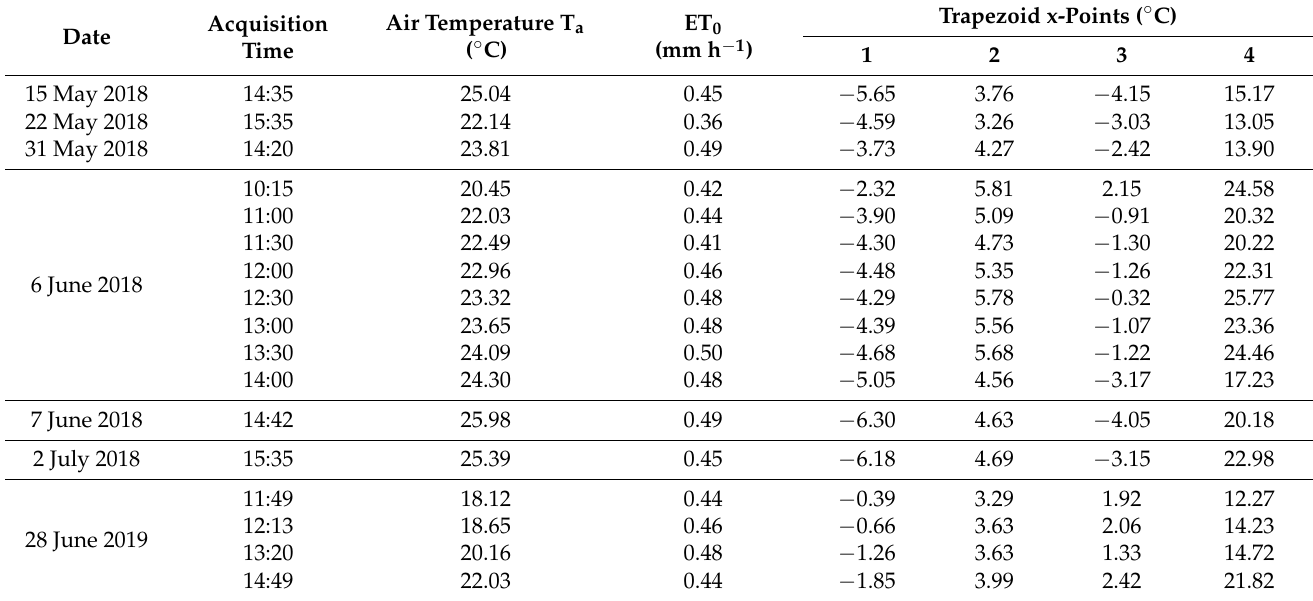
Figure 1. Vegetation index/temperature trapezoids developed from the UAS and meteorological data during the winter wheat season in 2018 in Denmark. I0, I1 and I2 denote minimum, optimum and full irrigation, respectively (see Table A2 in the Appendix A for irrigation time and amount). Table 1. Vegetation index/temperature trapezoid parameters depicting the four baseline points: (1) Well-watered and fully transpiring crop canopy, (2) dry and non-transpiring crop canopy, (3) saturated bare soil, (4) dry bare soil. Values were developed from meteorological data of May–July 2018 and June 2019 at the times of the UAS flights. Reference evapotranspiration ( ET 0 ) was calculated with the Penman-Monteith equation at the hourly